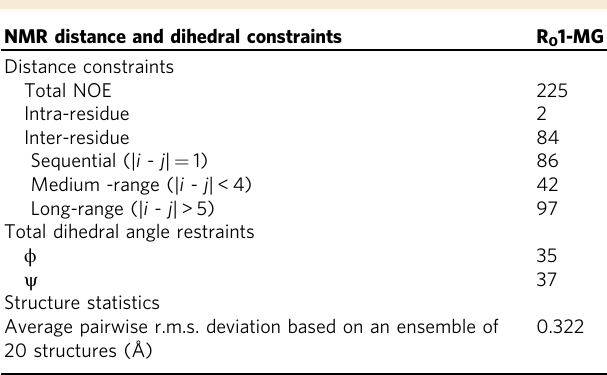
Table 1 NMR re fi nement statistics